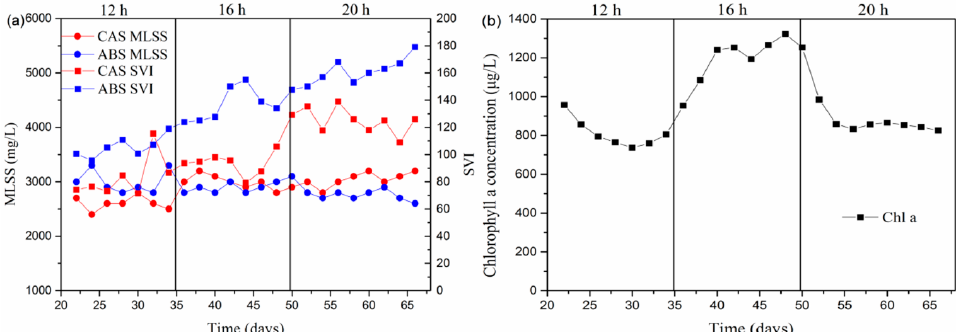
Figure 7. Biochemical indicators of the CAS system and ABS system ( a ), and chlorophyll a concentration of ABS system under different HRTs ( b ).